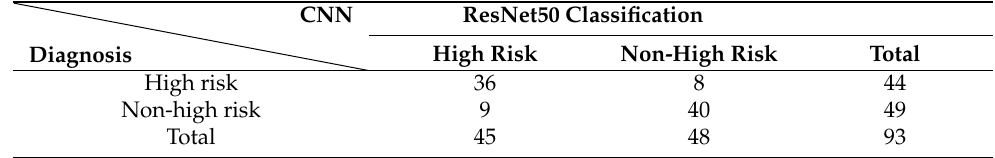
Table 2. Accuracy of multi-view CNN-ResNet50 for the prediction of rupture.